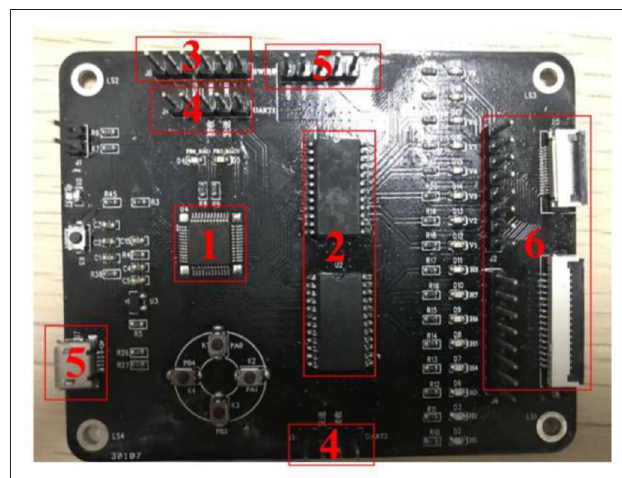
FIGURE 9 | Driving system hardware physical